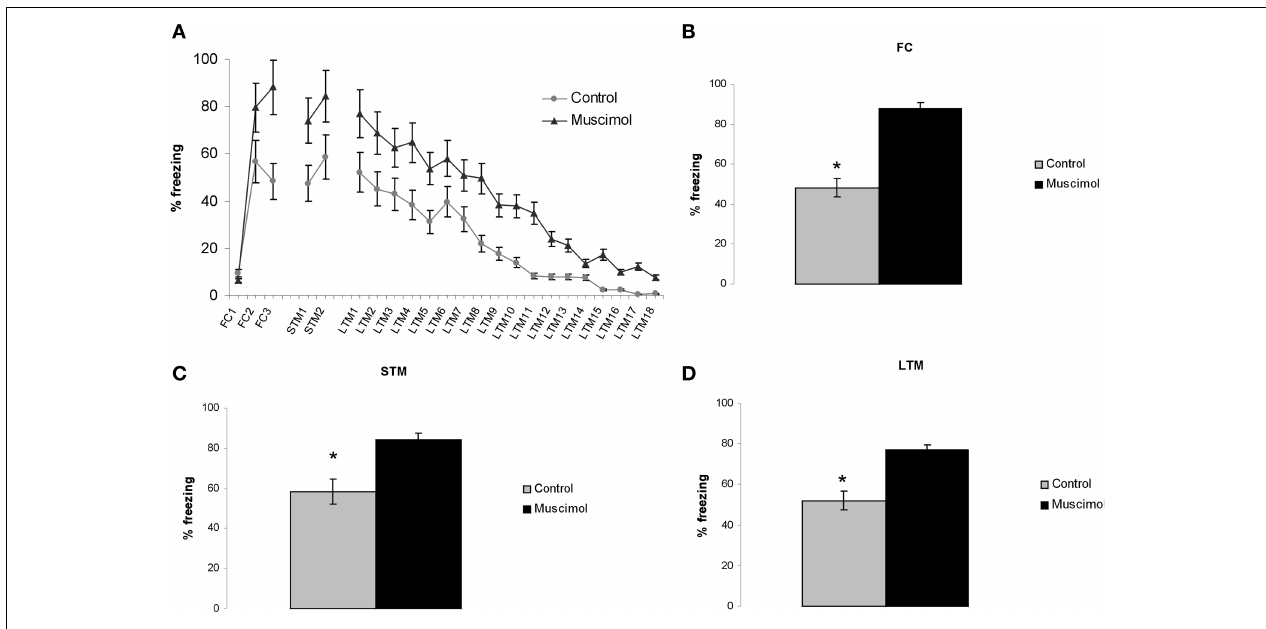
FIGURE 4 | Intracranial injections of 0.03 nM muscimol into the LA enhanced fear learning and memory. (A) Image shows the mean ± SE percent freezing during the test tone presentations for rats injected before conditioning with 0.03 nM muscimol ( n = 6) and saline ( n = 7). (B–D)